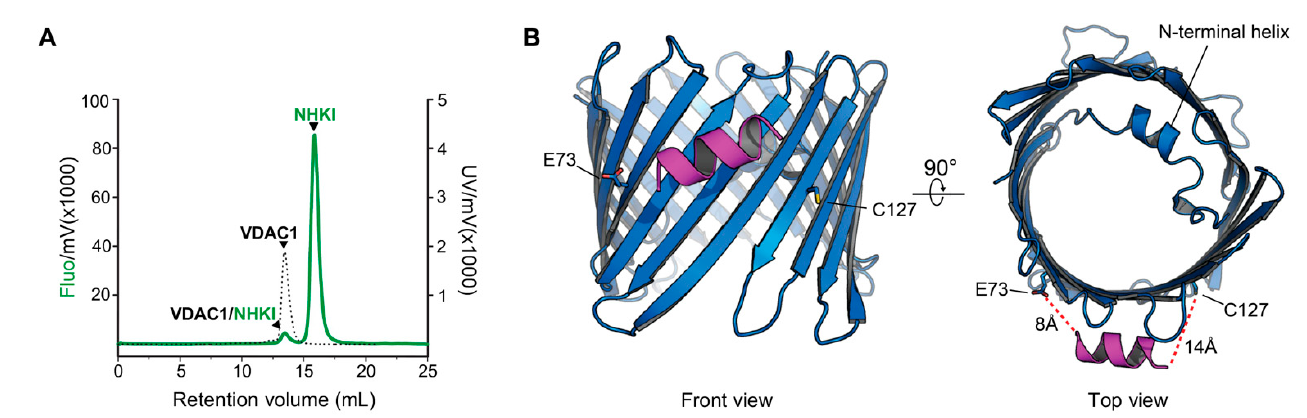
Figure 6. NHK1 peptide interacts with VDAC1 in a two-component system. ( A ) Analysis of VDAC1/NHK1-FITC interaction by FSEC. After incubation, complexes were separated by size-exclusion chromatography and detected by the fluorimeter. In green, the elution profile obtained at the emission wavelength of the FITC molecule; in dashed black, the elution profile obtained at 280 nm corresponding to the VDAC1 peak. ( B ) Molecular docking simulation result of the interaction between VDAC1 (in blue) and NHK1 peptide (in purple).